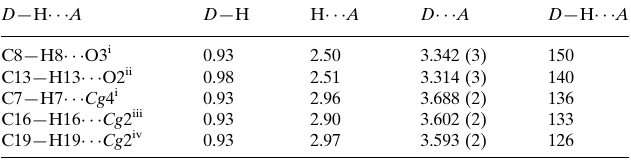
Hydrogen-bond geometry (A˚ , (cid:2) ). Cg 2 and Cg 4 are the centroids of rings C1–C6 and C14–C19,